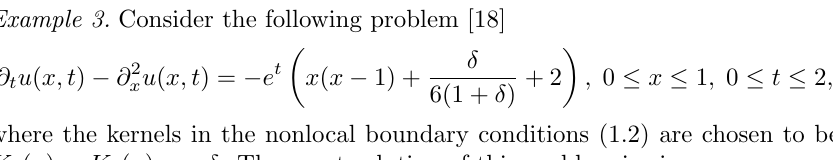
Figure 2. Left: L 2 and L ∞ -errors versus N in log-scale. Right: Point-wise errors at t = 1 with ∆t = 10 − 4 and N = 20.